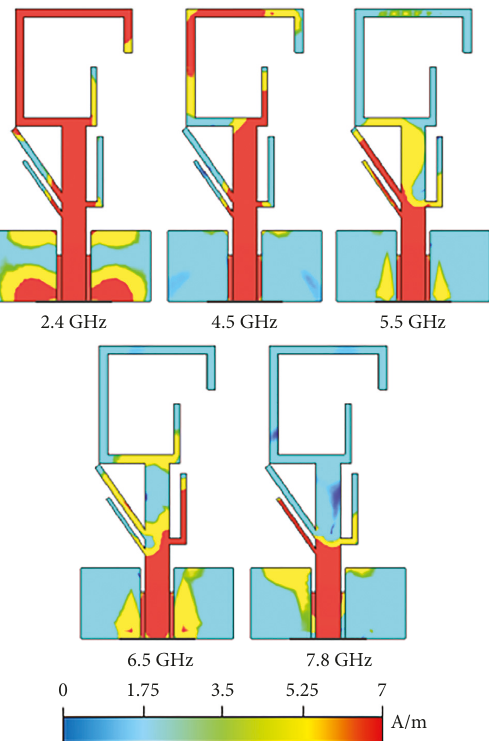
Figure 10: Current density distribution for various operating frequencies.